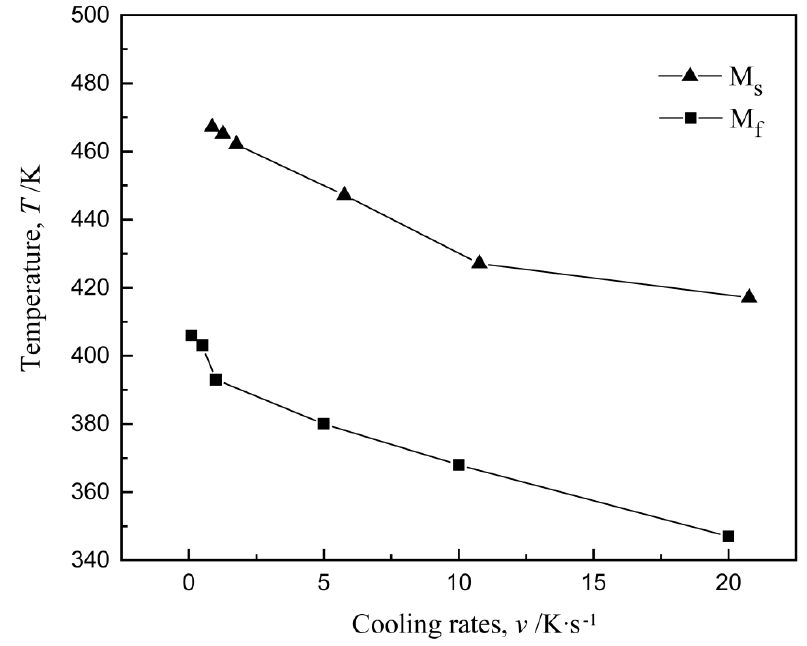
Figure 9. M s and M f of as-cast AISI M42 HSS under different cooling rates.